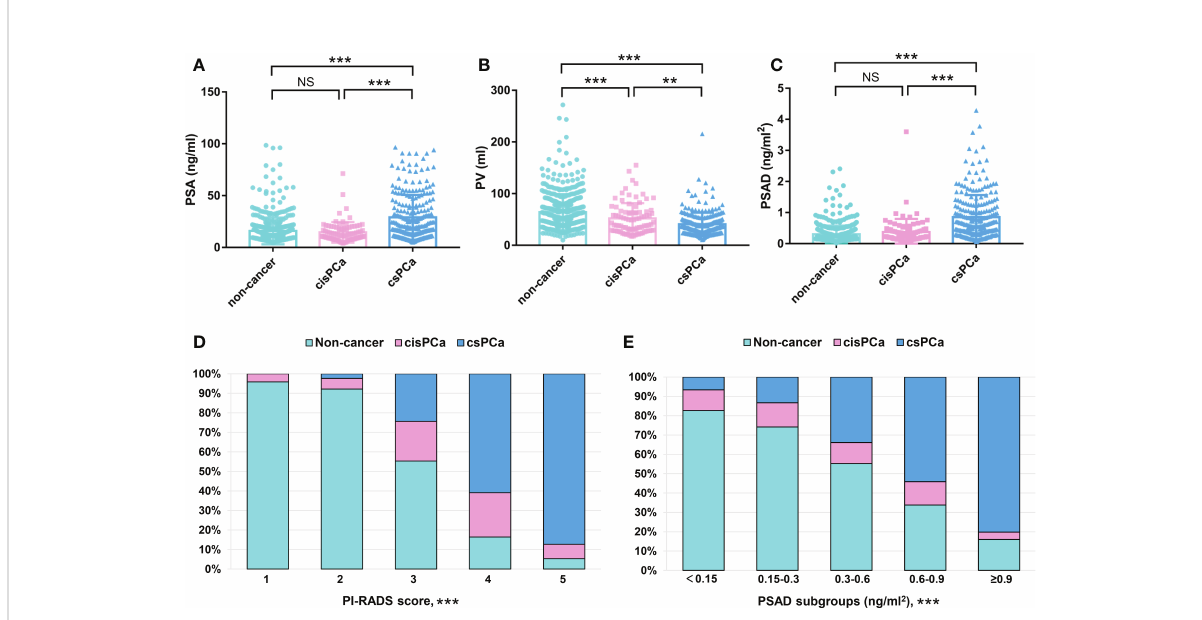
FIGURE 1 Comparisons of the clinical variables among the non-cancer, csPCa, and cisPCa patients: (A) total PSA; (B) PV; (C) PSAD; (D) PI-RADS score; (E) PSAD subgroups. **P < 0.01; ***P < 0.001; NS, not signi fi cant.